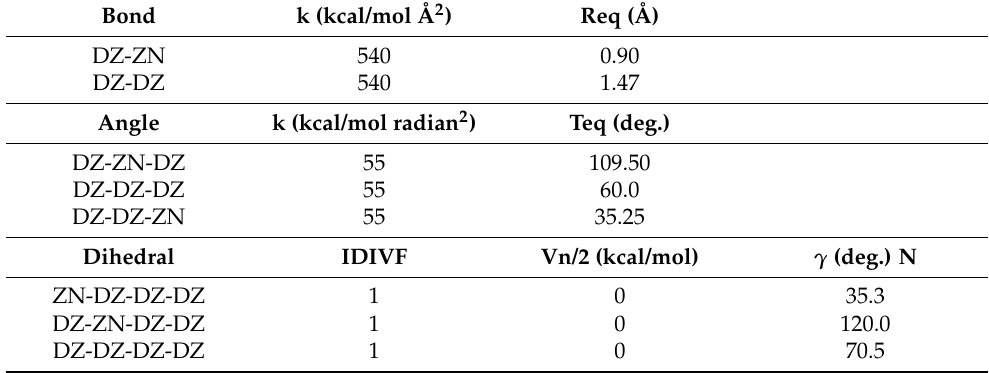
Table 3. Bonded force field parameters of the tetrahedral zinc ion coordinated by four dummy